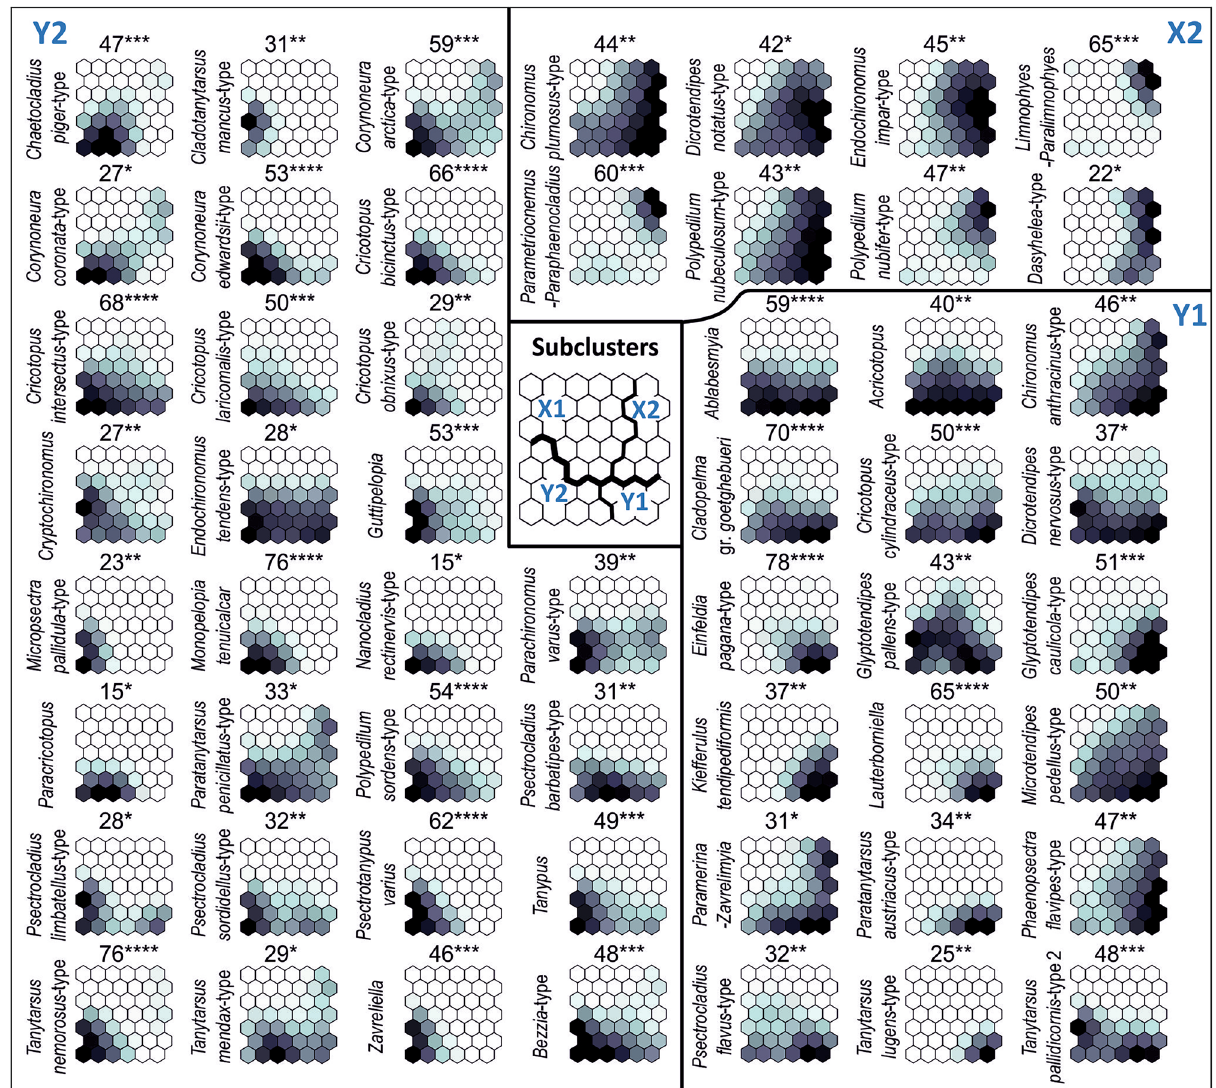
Figure 4. Fifty five dipteran taxa significantly ( p ≤ 0.05) associated with SOM subclusters X2, Y1 and Y2 (respectively, 8, 19 and 28 taxa). No palaeoindicator was significantly associated with subcluster X1. The shading is scaled independently for each taxon; it is darker for a stronger association in virtual core samples. Maximum observed indicator value (IndVal) is shown above each taxon plane; IndVals and their significance levels were calculated on the basis of real core samples. The plane for Procladius (56***), which is indicative of subcluster Y1, is not presented for graphical reasons; it resembles the plane for Ablabesmyia